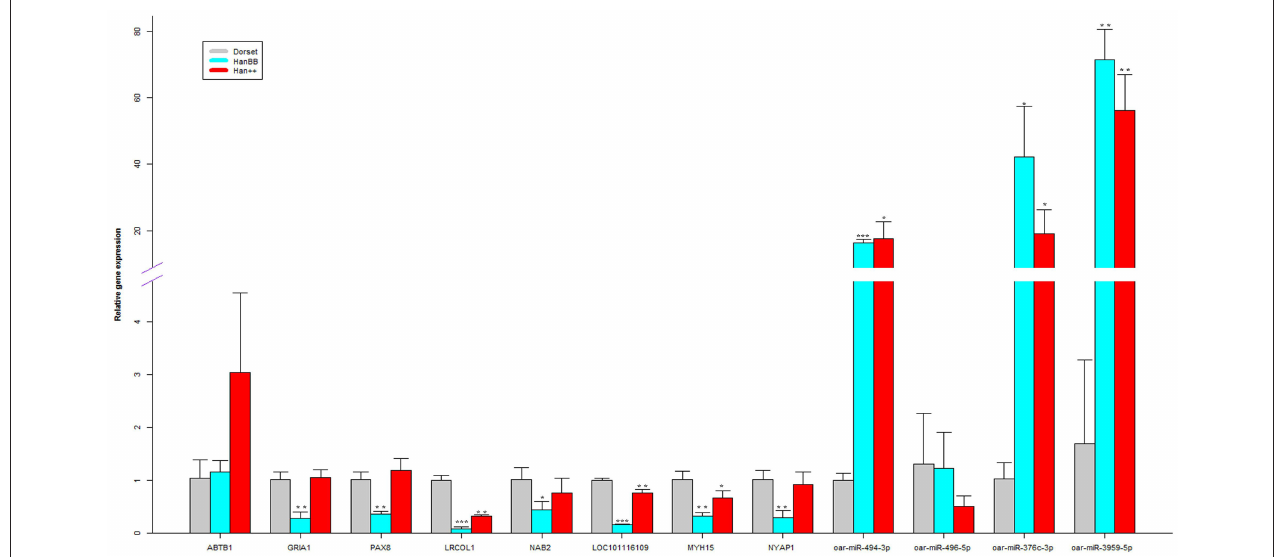
FIGURE 5 | Validation of the RNA-Seq data by real-time quantitative PCR. The relative expression levels of each mRNA and lncRNA were normalized to 18S rRNA, and each miRNA was normalized to 5S rRNA. * p < 0.05, ** p < 0.01, and *** p < 0.001,